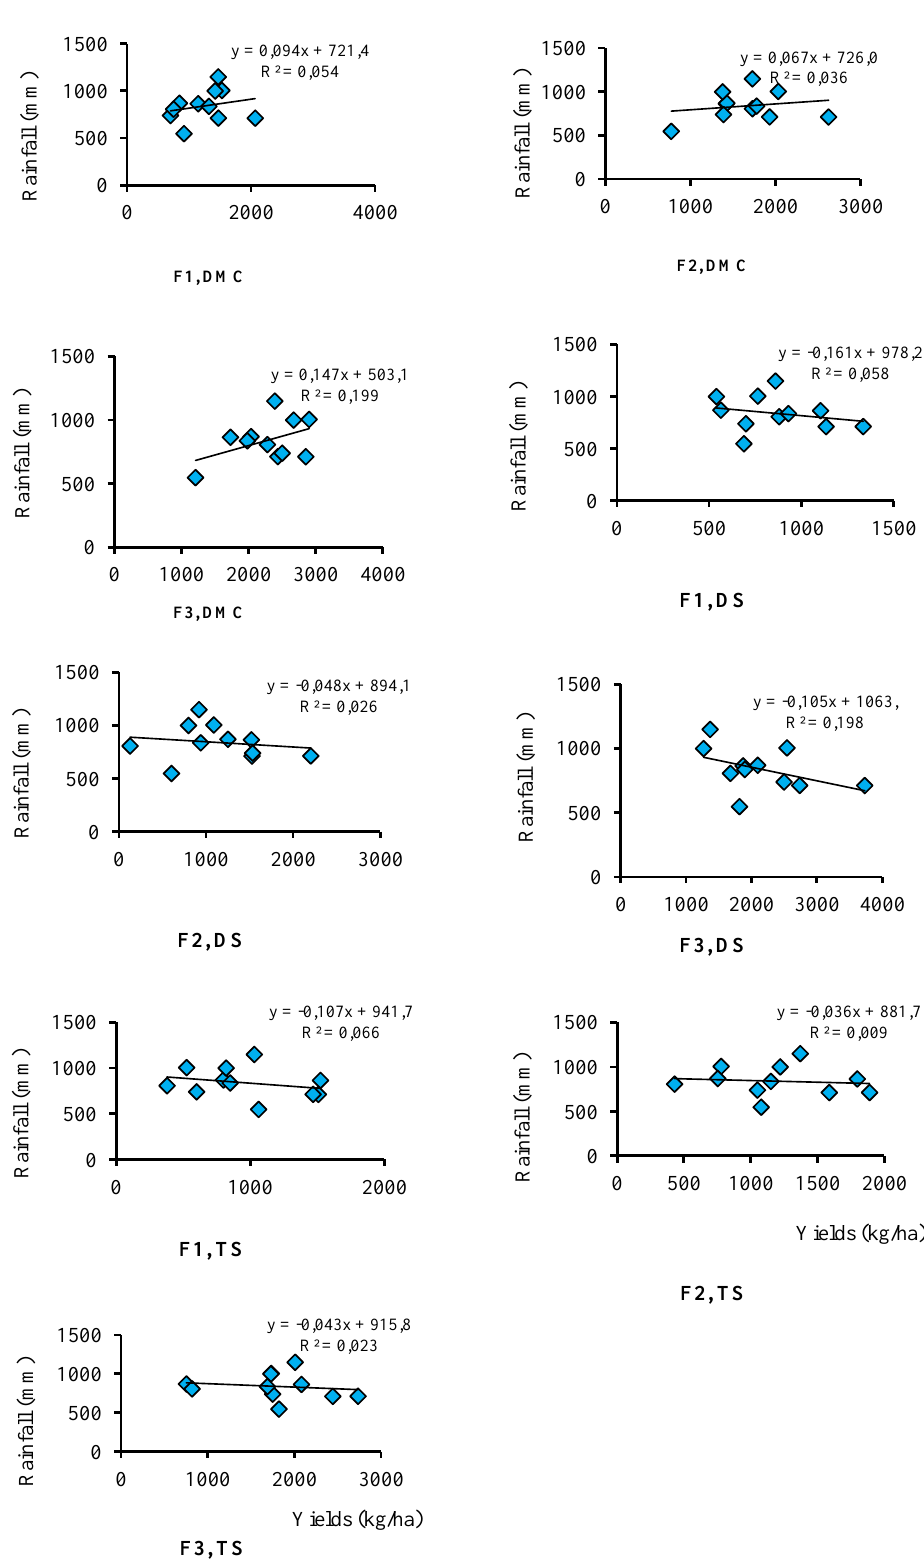
Figure 3. Plots of annual rainfall vs. yields in the three cropping systems and corresponding levels of fertilization.